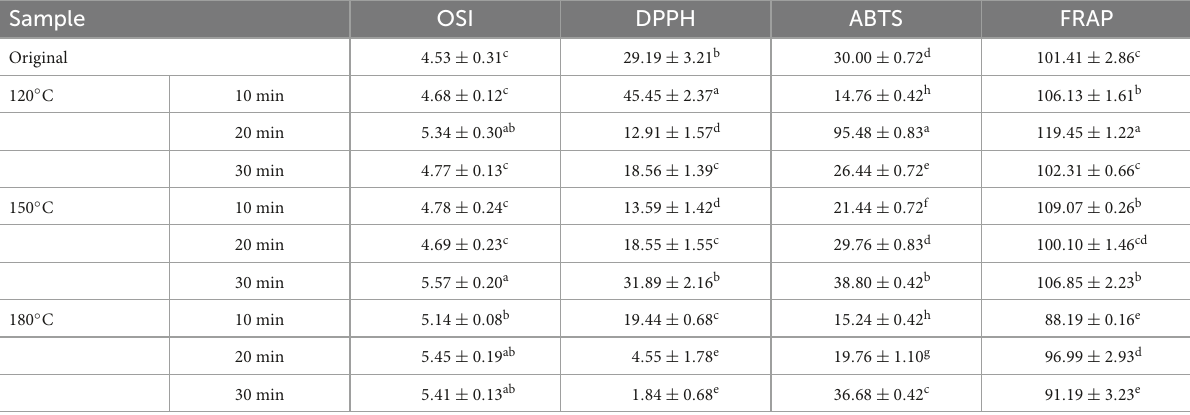
TABLE 3 Oxidative stability index (h) and free radical scavenging capacity ( µ mol TE/L) of walnut oil by roasted walnut kernels with different temperature and duration. Sample